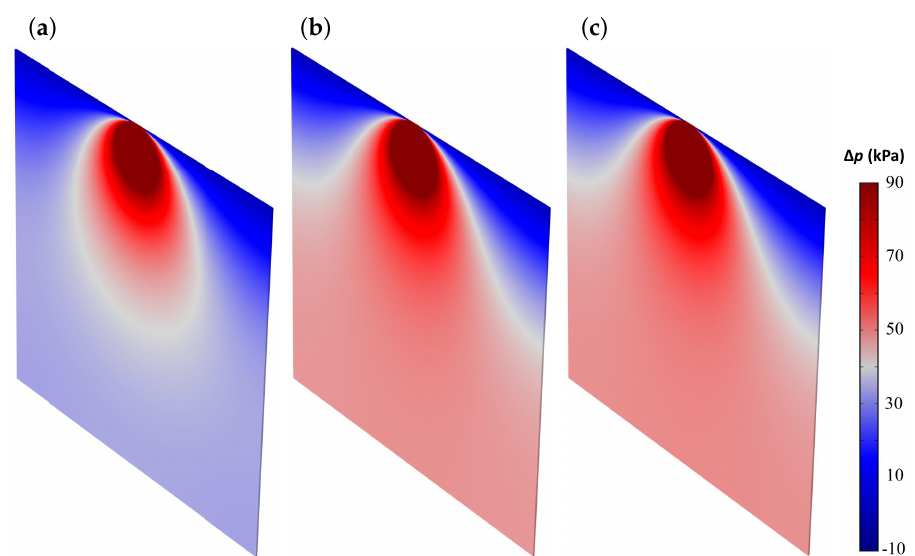
Figure 10. Effect of fault permeability on the pore pressure diffusion after 2.5 years of operation of an annual regulation reservoir. Here we show the contour plots of the pressure build-up on three faults with permeability values k F = 10 − 11 ,10 − 10 and 10 − 9 m 2 on panels ( a )–( c ), respectively. The resevoir level is at its maximum value after 2.5 years of operation. Table 3 lists the hydro-mechanical properties of the fault and the host rock. ( a ) k F = 10 − 11 m 2 , ( b ) k F = 10 − 10 m 2 , ( c ) k F = 10 − 9 m 2 .